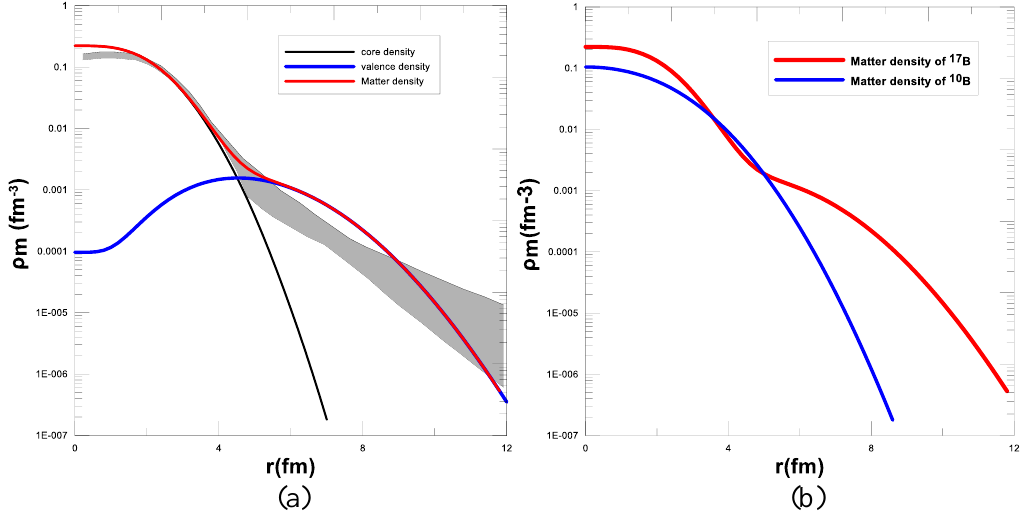
Figure 1: (a) The comparison between Matter density distributions of 17 B with that of experimental data, (b) The comparison between matter density distribution of 17 B and 10